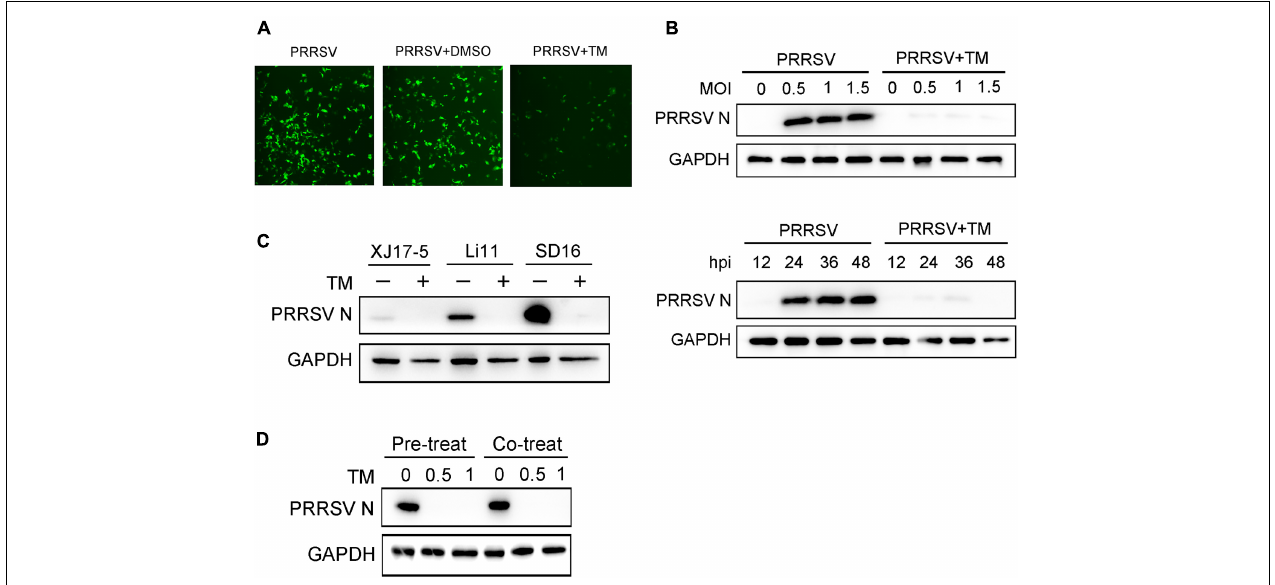
FIGURE 2 | Induction of UPR effectively suppresses the replication of PRRSV. (A) Marc-145 cells were infected with PRRSV (MOI = 1) in the presence (1 µ g/ml) or absence of TM, and DMSO is used as a control. PRRSV N protein (green) is shown using immunofluorescence analysis (Bar, 200 µ m). (B) Western blot was used to analyze the viral N protein levels in Marc-145 cells at different PRRSV MOIs (MOI = 0, 0.5, 1, and 1.5) or different infection periods (12, 24, 36, and 48 hpi) in the presence or absence of TM (1 µ g/ml). DMSO serves as a negative control. (C) Marc-145 cells were treated or mock-treated with TM in the presence of different strains of PRRSV (XJ17-5, Li11, and SD16); Western blot was used to detect the expression of PRRSV N. (D) Marc-145 cells were pre-treated with different concentrations of TM (0, 0.5, and 1 µ g/ml) for 4 h, and then infected with PRRSV (MOI = 1) for another 24 h; PRRSV N protein level is shown using Western blot analysis. Meanwhile, cells were co-treated with different concentrations of TM (0, 0.5, and 1 µ g/ml) and PRRSV (MOI = 1) for 24 h. Western blot was used to analyze the expression of PRRSV N. Data are representative of the results of three independent experiments.